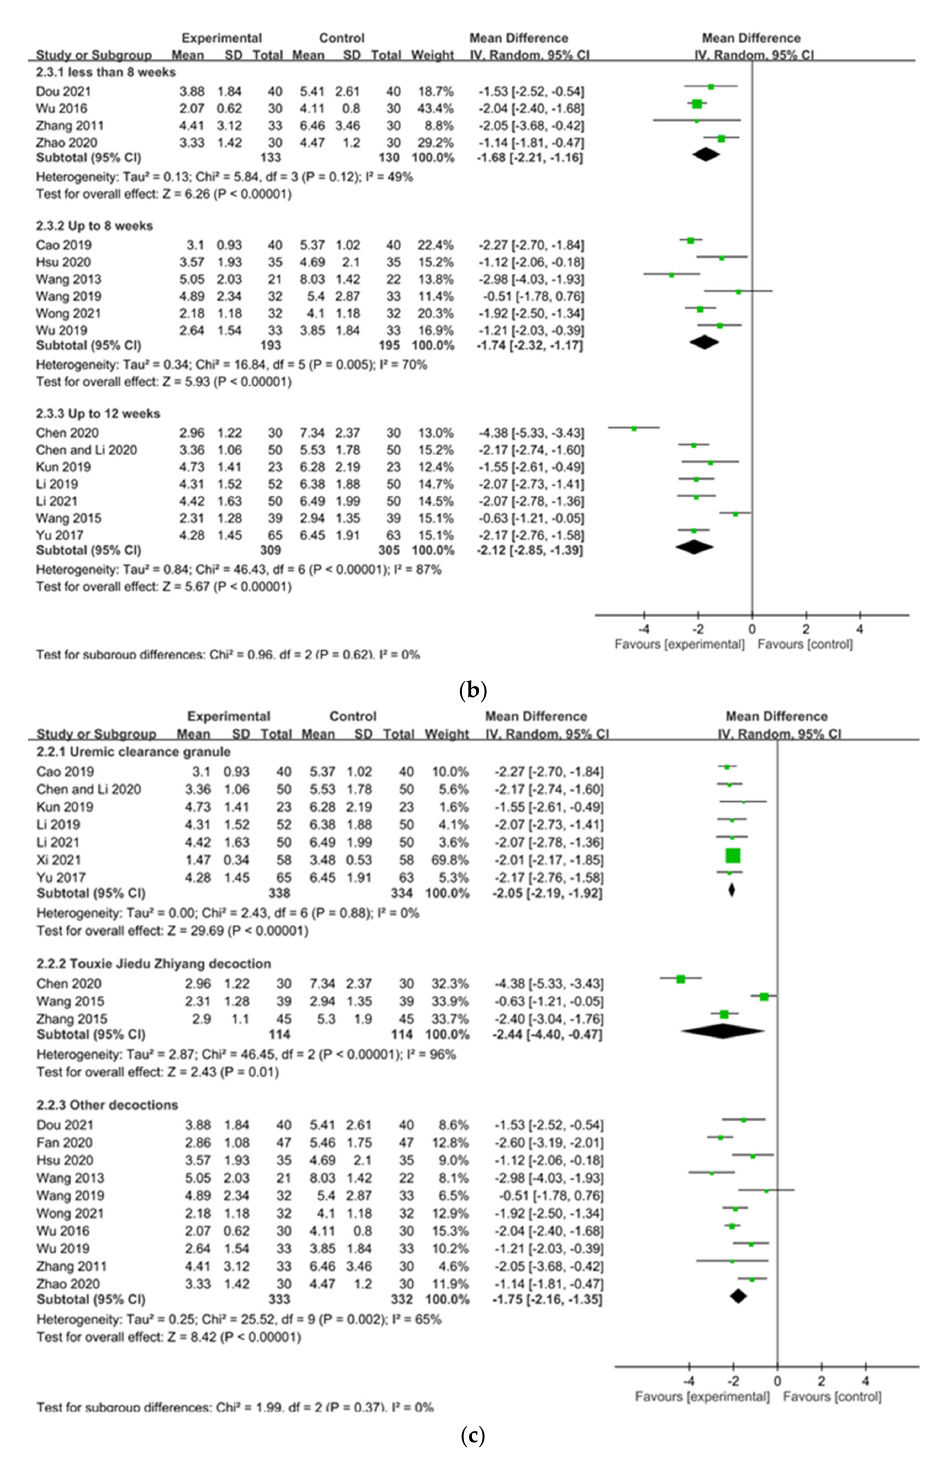
Figure 3. Forest plot of pruritus score (visual analog scale (VAS)) in patients with uremic pruritus treated with Chinese herbal medicine (CHM): ( a ) VAS score in included studies; ( b ) VAS score in durations of CHM treatment in dialysis patients; ( c ) VAS score in different Chinese herbal formulas. The Duo and Dirk R. Kuypers itching scales for pruritus assessment were reported by seven [26,34,35,53–55,63] and two studies [31,36], respectively. CHM significantly reduced pruritus symptoms according to both the Duo (MD − 6.11, 95% CI − 8.28 to − 3.94) and Dirk R. Kuypers (MD − 5.12, 95% CI − 6.49 to -3.75) itch-intensity scales (Figure 4a,b). Hetero- geneity across trials was high for VAS scores (I 2 = 75%, p < 0.00001, VAS scores ≥ 8